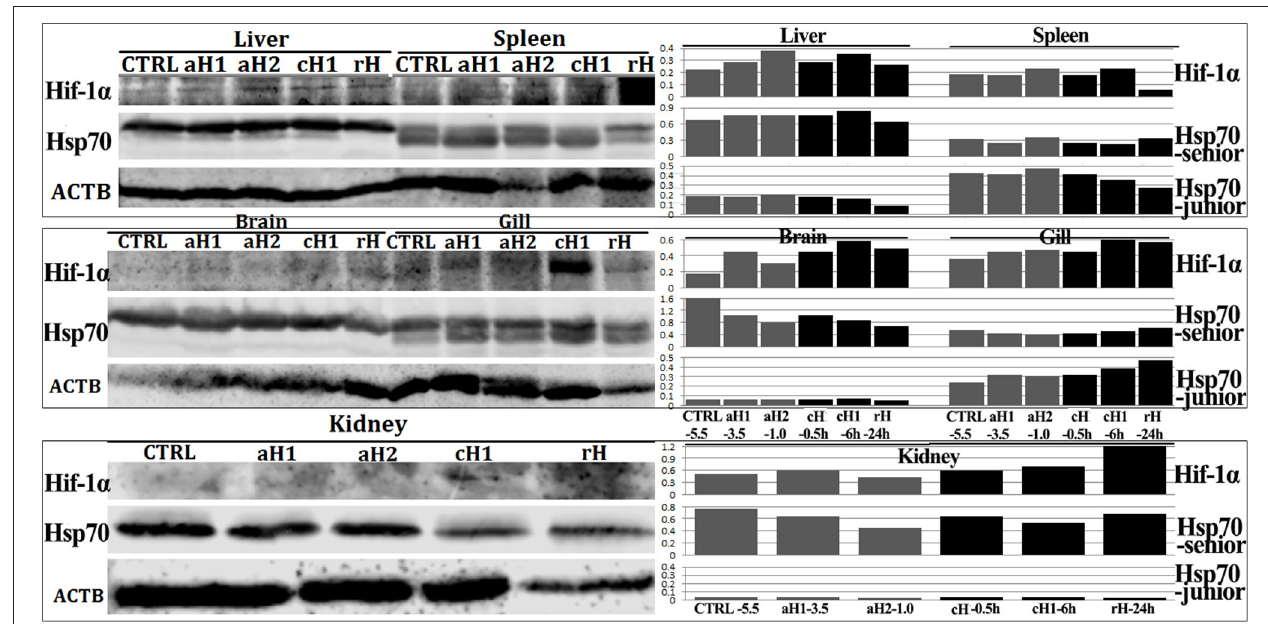
FIGURE 4 | Western blot analysis of Hif-1 α and Hsp70 proteins in different tissues after hypoxia treatment in M. amblycephala . CTRL-5.5, the control; aH1-3.5 and aH2-1.0, acute hypoxia at 1.0 and 3.5mg/L of DO last for 0.5h, respectively; cH-0.5h and cH1-6h, comparable-acute hypoxia (DO: 3.5mg/L) last for 0.5 and 6h, respectively; rH-24h, hypoxia (DO: 3.5mg/L) last for 6h and then recover to DO: 5.5mg/L for 24h. The lower band in liver, spleen and gill is the junior Hsp70 protein generated by IRES-mediated translation. The left sides are western blot result, while the right sides are corresponding ratio of gray values of Hif-1 α and Hsp70